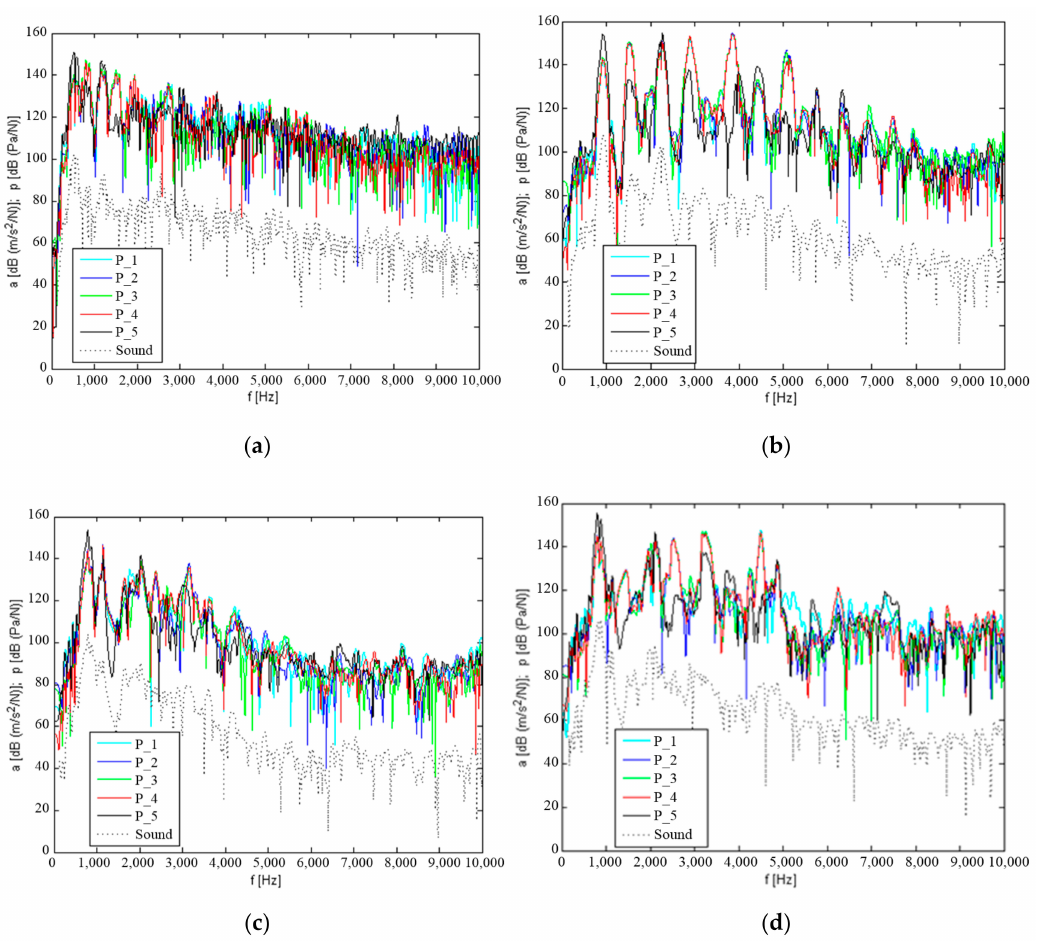
Figure 7. Natural and mutual transmittance of vibration response to impulse induction at point P_1 and sound level above the housing: ( a ) Steel housing, ( b ) K_1 housing, ( c ) K_2 housing, and ( d ) K_3